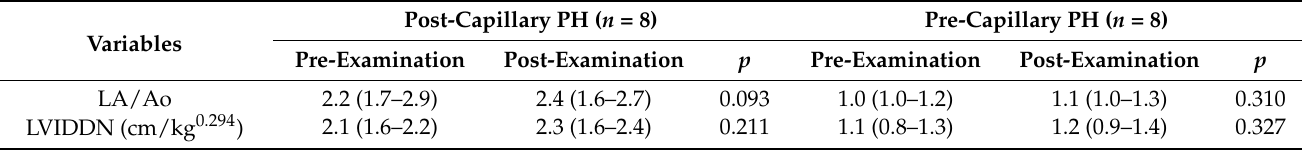
Table 4. Results of echocardiographic variables for right heart morphology and function in dogs with post-capillary and pre-capillary pulmonary hypertension before and after beraprost sodium administration.